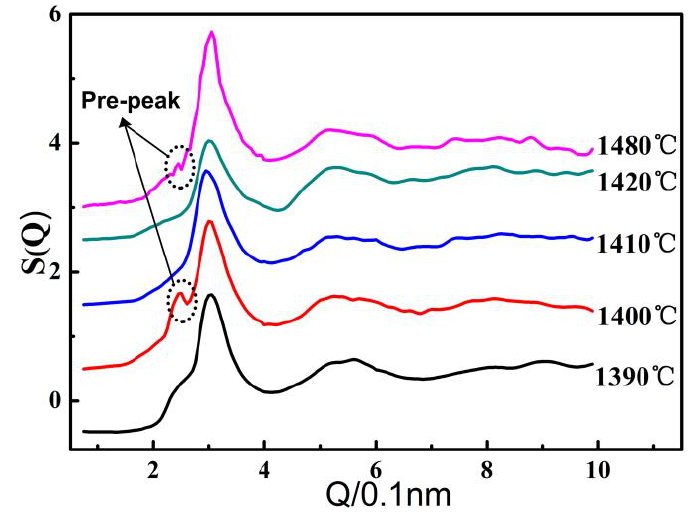
Figure 9. Temperature dependence of total structure factors of the Ni-Cr-W superalloy.